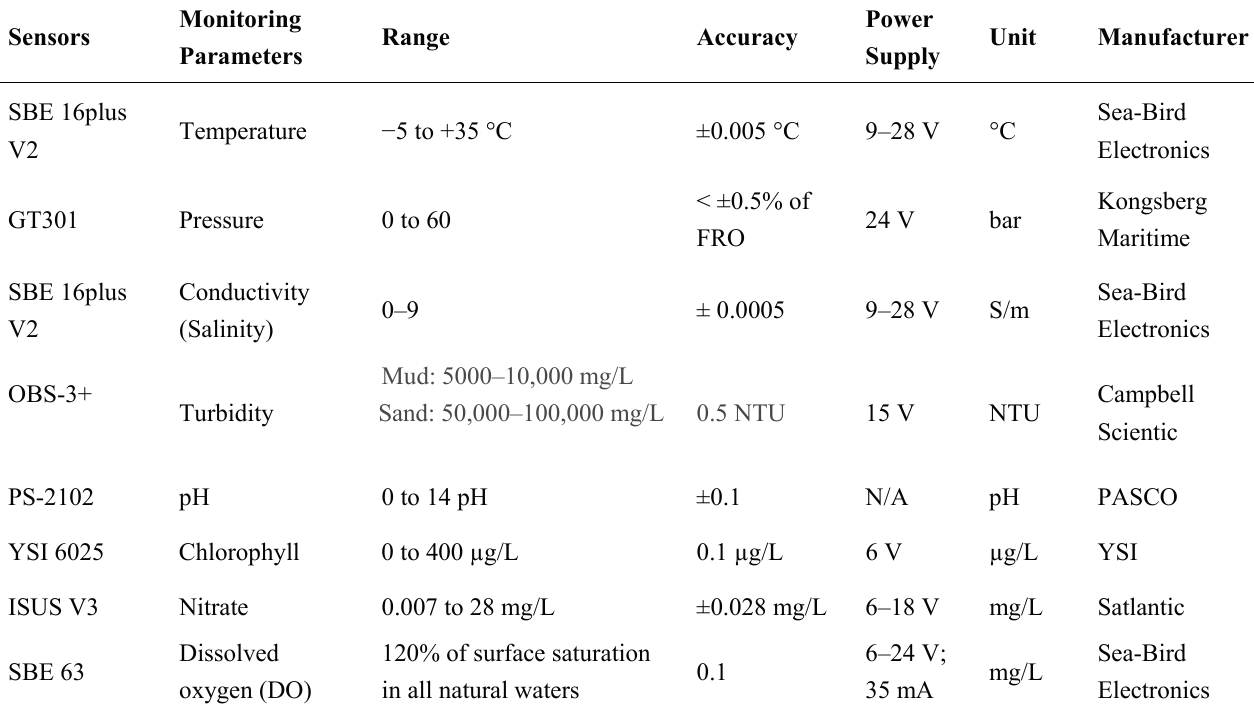
Table 1. Common marine environment monitoring